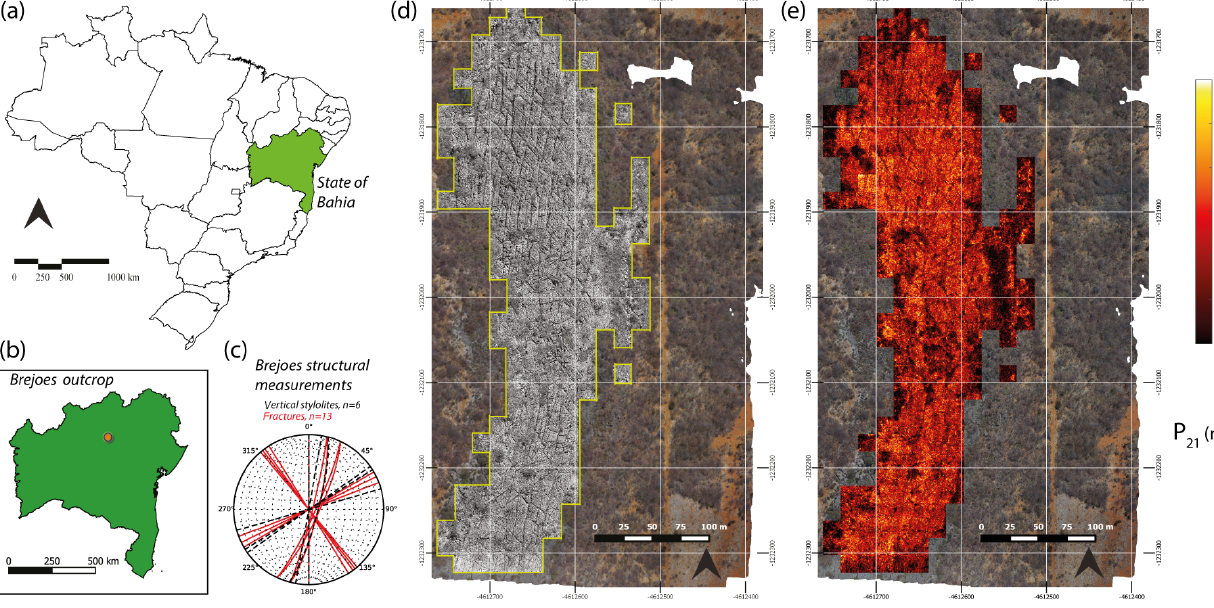
Figure 11. Trace extraction results from the Brejões outcrop. (a) Bahia state in NE Brazil. (b) Location of the Brejões outcrop in the state of Bahia. (c) Structural measurements from Brejões outcrop, adapted from Boersma et al. (2019). (d) Selected tiles from the Brejões orthomosaic (Prabhakaran et al., 2019a) for the automated extraction. (e) Spatial variation in the fracture intensity depicted as a P 21 plot computed using the box counting method. Maps depicting administrative boundaries of Brazil and Bahia state was modified from free vector spatial data downloadable at DIVA-GIS (https://www.diva-gis.org/Data, last access: 14 April 2019). The Brejões dataset (Prabhakaran et al., 2019a) is available under a CC-BY-NC-SA